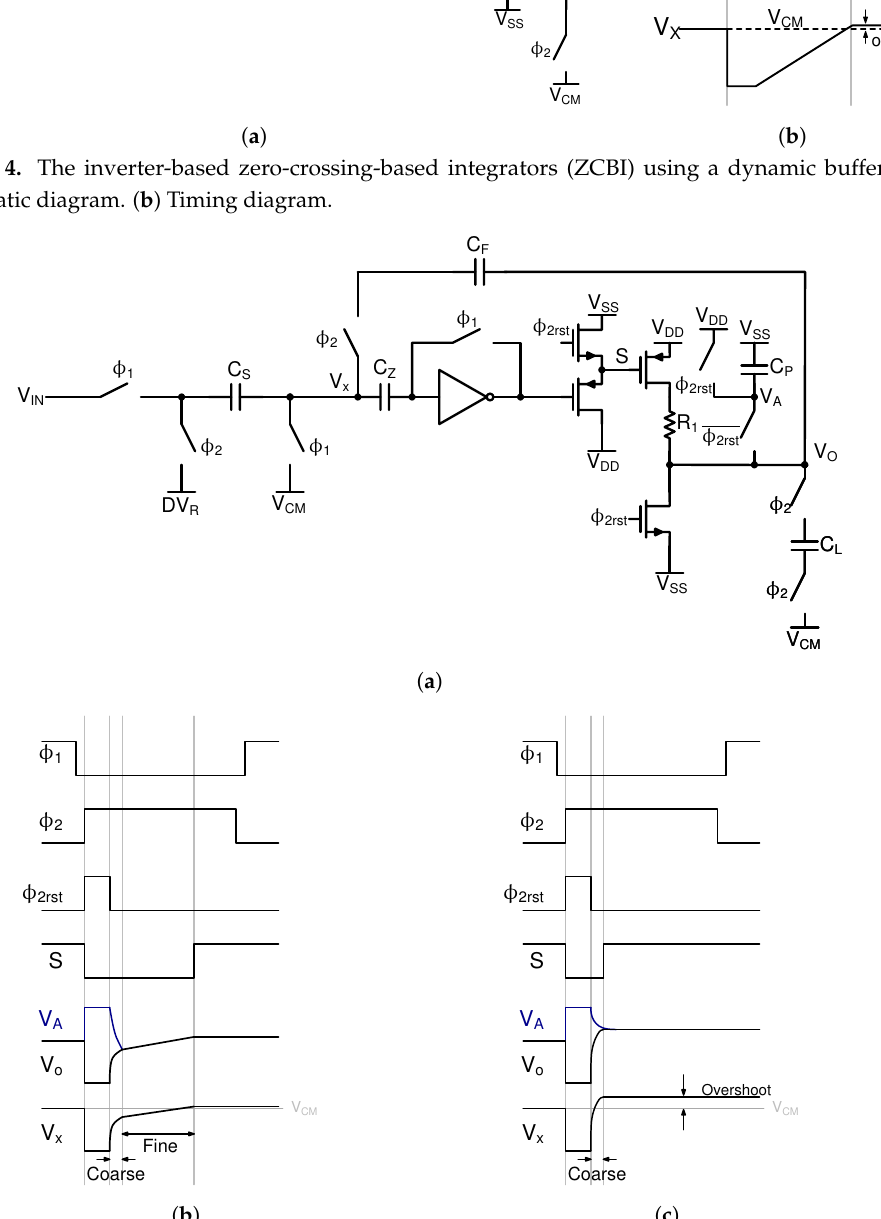
Figure 5. The ZCBI employing the charge-sharing-based two-phase charging scheme. ( a ) Schematic diagram. ( b ) Normal operation. ( c ) Erroneous